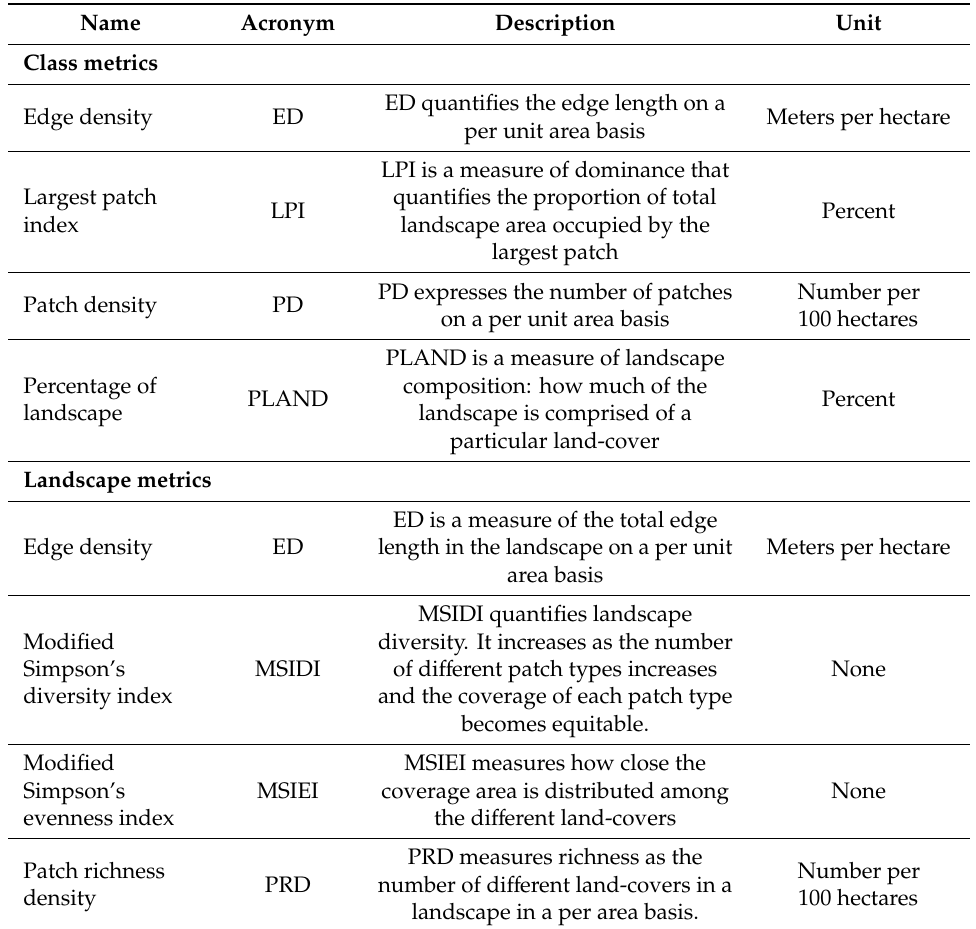
Table 1. Landscape metrics used to describe the urban landscape in the city of Niamey (adapted from McGarigal et al.